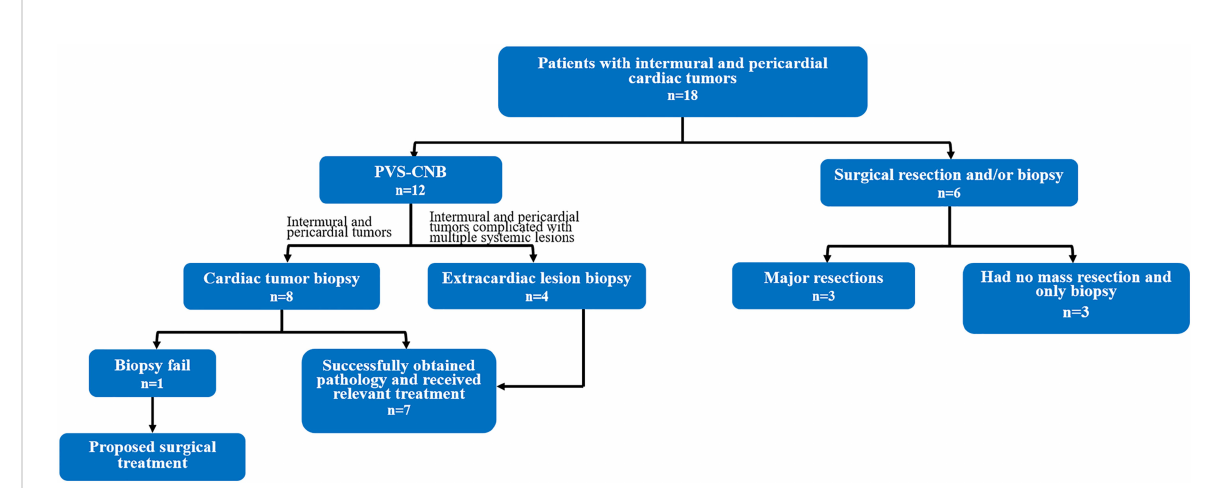
FIGURE 5 A schematic that demonstrate the procedure and/or the instrument